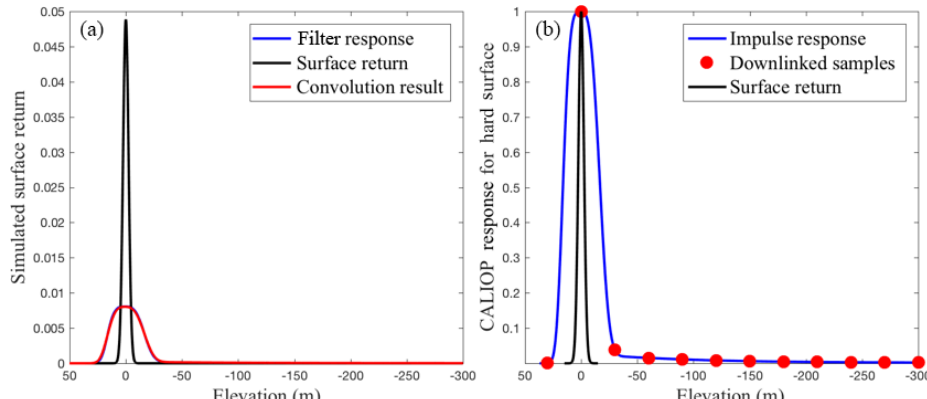
Figure 1. (a) Simulated low-pass filter response (blue), surface return (black), and the convolution result of the surface return and low-pass filter (red); note that the blue curve is completely overwritten by the red curve. (b) CALIOP impulse response function for hard surface (blue), the downlinked 30m vertical resolution samples (red circles) and the simulated peak-normalized surface return (black). Note that the downlinked samples in this example have no time delay, and the surface elevation is assumed to be at 0m. The elevations below the surface are set to negative numbers.